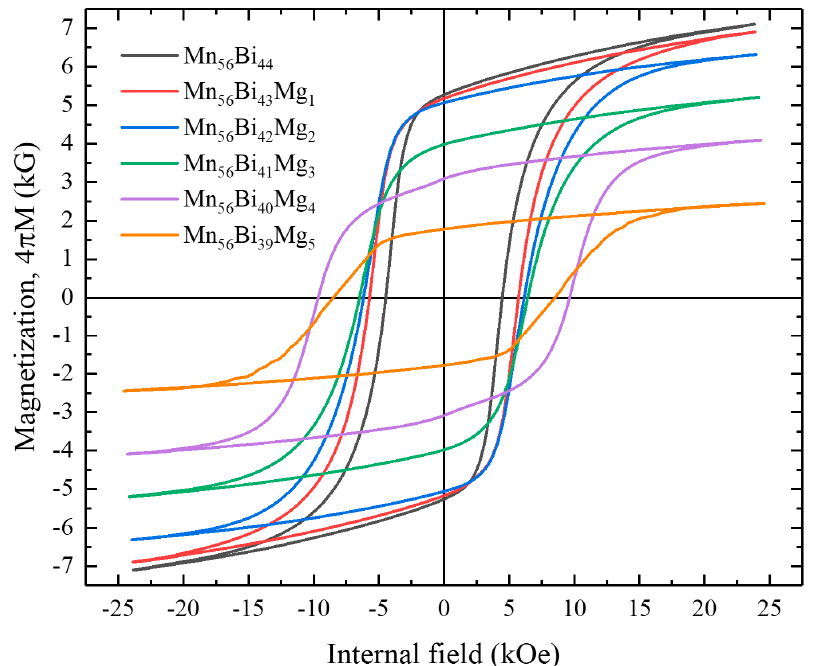
Figure 5. Magnetic hysteresis loops of Mn 56 Bi 44 − x Mg x (0 ≤ x ≤ 5) bulk samples. Nanomaterials 2020 , 10 , x FOR PEER REVIEW